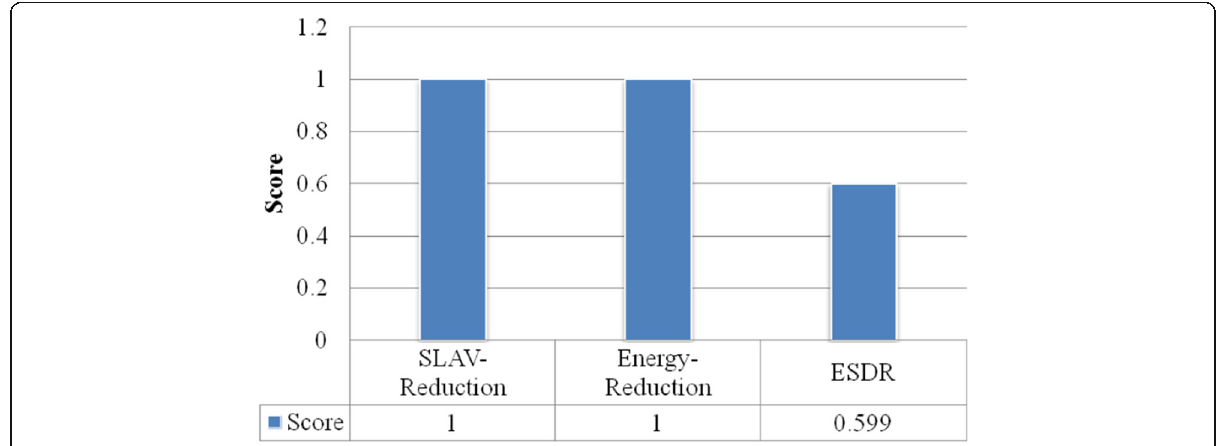
Fig. 6 Comparison of score in different